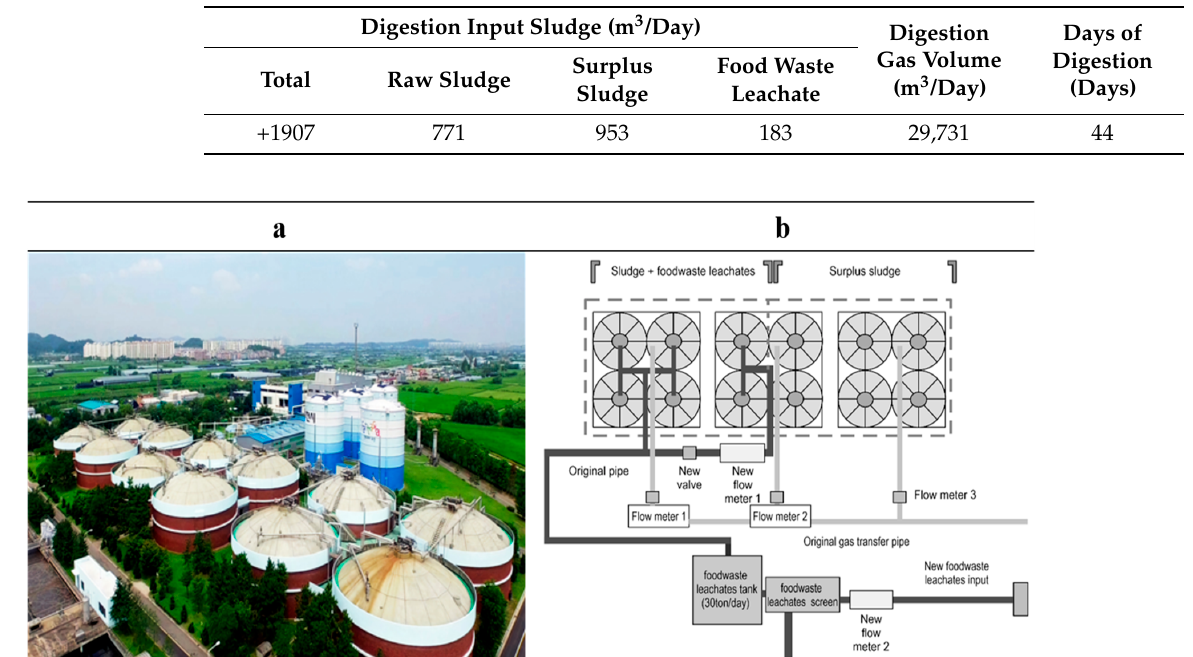
Figure 1. Schematic of the B wastewater treatment plant: full-scale plant ( a ); construction design ( b ).